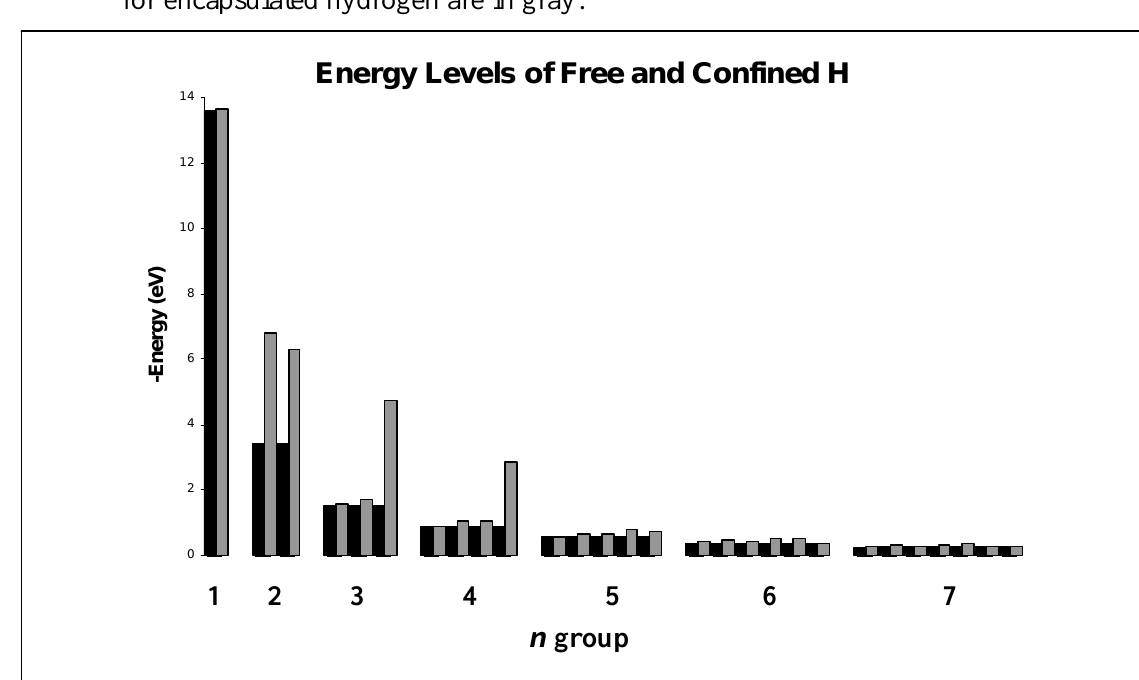
Figure 1. Comparison of free and encapsulated (“confined”) hydrogen energy levels in eV for n =1-7 as calculated in our work. Results are grouped by principal quantum number n and are arranged within each group by increasing angular momentum quantum number (cid:65) . Free hydrogen energies are in black and those for encapsulated hydrogen are in gray.